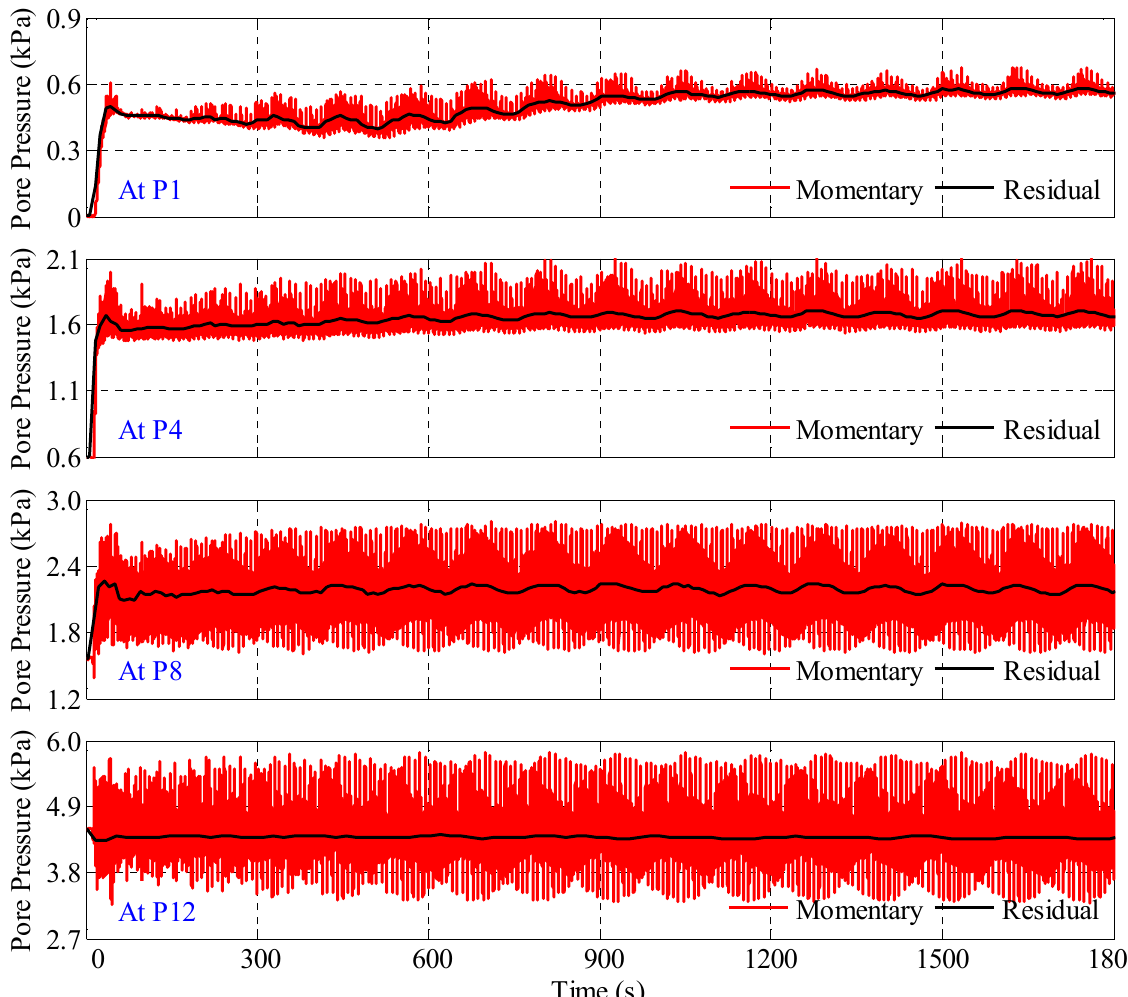
Figure 13. Momentary and residual pore pressure recorded at P1, P4, P8 and P12 in Test 3 (in the first 30 min).